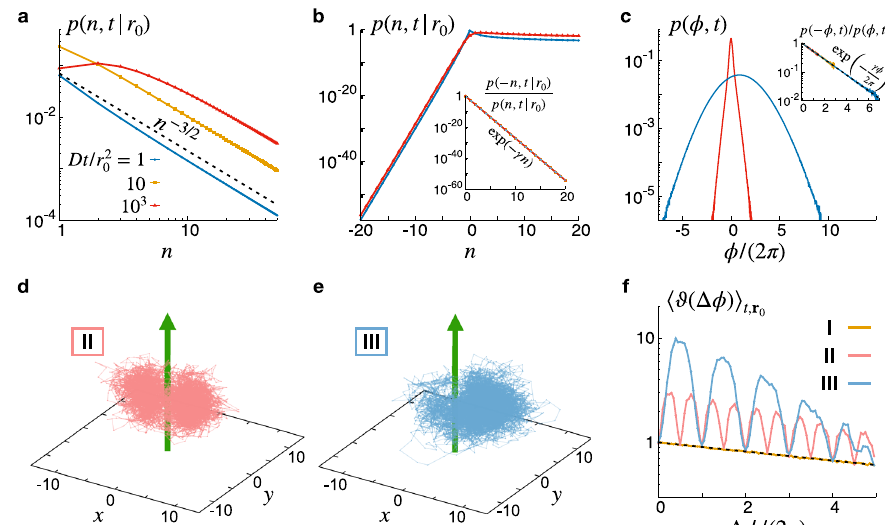
Fig. 2 The topological fl uctuation theorem for a single vortex. a The exact winding number distribution for a free vortex exhibits a power law scaling for large positive n values. b At all times t and initial radial position r 0 , the ratio of negative to positive winding number distributions maps onto the theoretical prediction (3) (inset) resulting in an exponential scaling of p ( n , t ∣ r 0 ) for large negative windings (caption in panel a ). c In the presence of boundaries restricting the particle motion with diffusivity D inside a disk of radius R and outside the vortex center, the winding angle distribution shows exponential tails at small times (red curve, Dt / R 2 = 0.1), while it becomes Gaussian for larger t (blue curve, Dt / R 2 = 10). The theorem holds irrespectively of the shape of the distribution (inset, the orange curve corresponds to Dt / R 2 = 1). d , e Representative trajectories corresponding to cases II and III discussed in the text. f The probability ratio (14) averaged over initial positions r 0 and trajectory times t as function of the total winding angle Δ ϕ for the three cases (case I corresponding to isotropic con fi nement) discussed in the text and Δ r = Δ z = 0. In a , b γ = 2 π , while in c – e γ = 0.1 × 2 π . In d – f we used k B T / k = 10, while